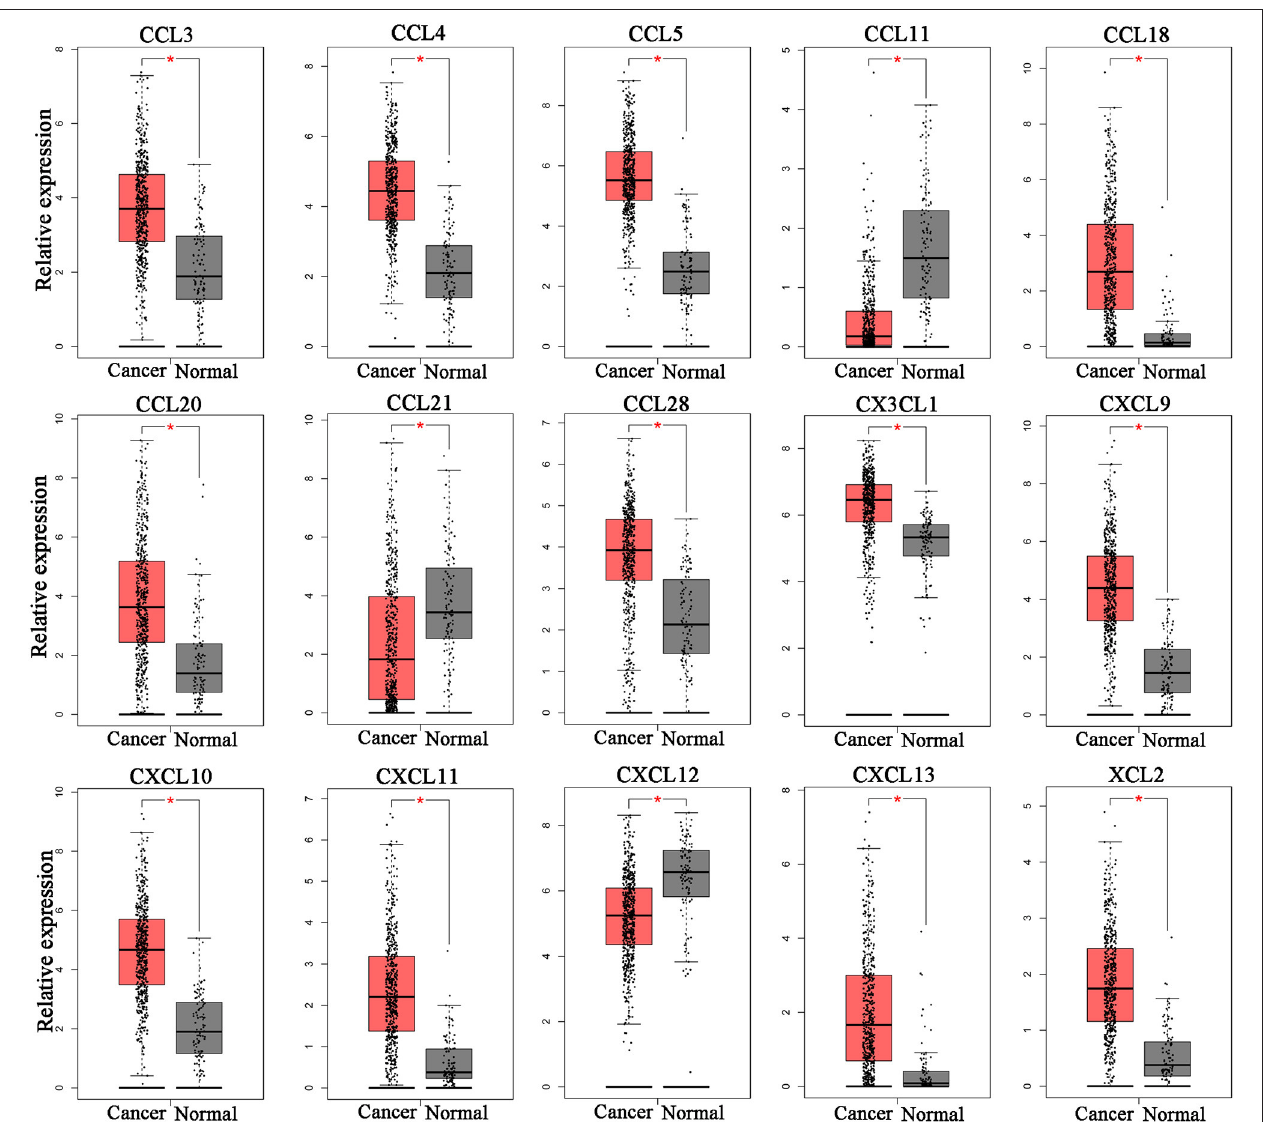
FIGURE 1 | Differentially expressed chemokine ligands between ccRCC tissues and normal tissues. 12 chemokine ligands (CXCL9, CXCL10, CXCL11, CXCL13, CCL3, CCL4, CCL5, CCL18, CCL20, CCL28, CX3CL1, and XCL2) were upregulated in ccRCC tissues compared with normal kidney tissues. 3 chemokine ligands (CCL11, CCL21, and CXCL12) were downregulated in ccRCC tissues compared with normal kidney tissues. (Student’s t -test, * P < 0.05).